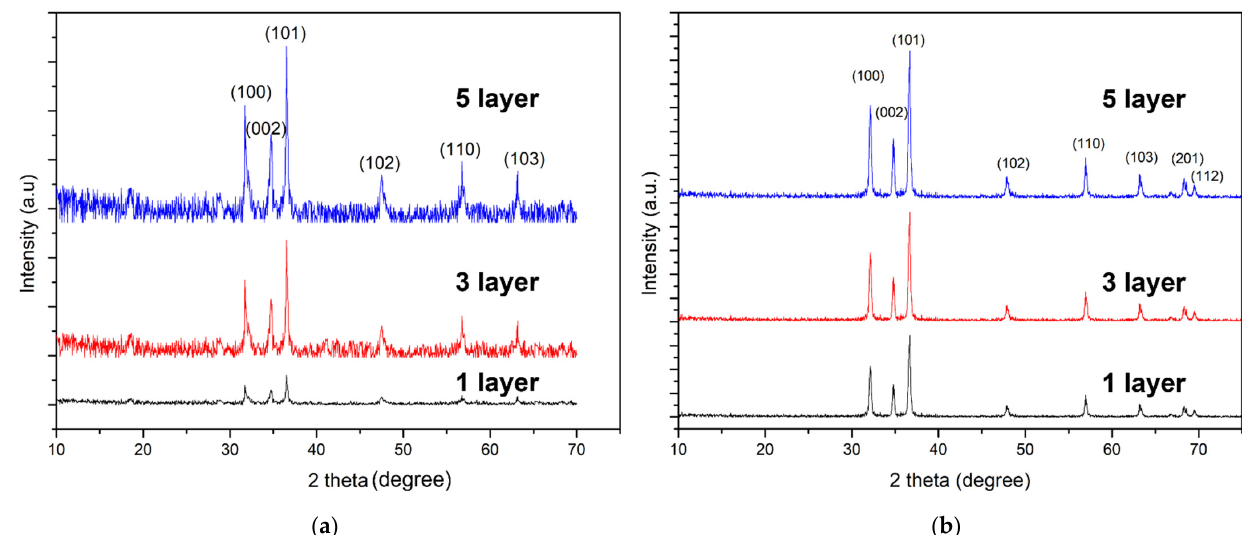
Figure 1. XRD results of the ( a ) ZnO seed layer ( b ) ZnO nanowires of different seed layer thickness.